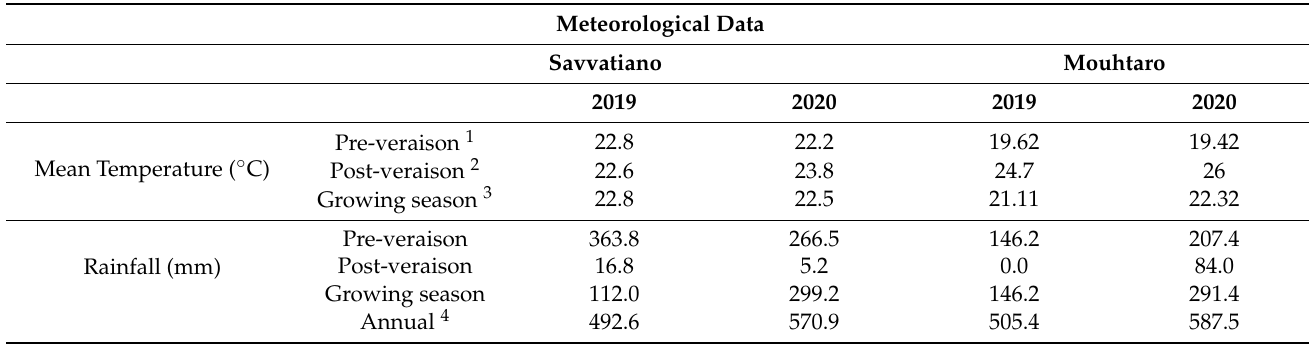
Table 1. Meteorological data of the Muses Valley area during 2019 and 2020